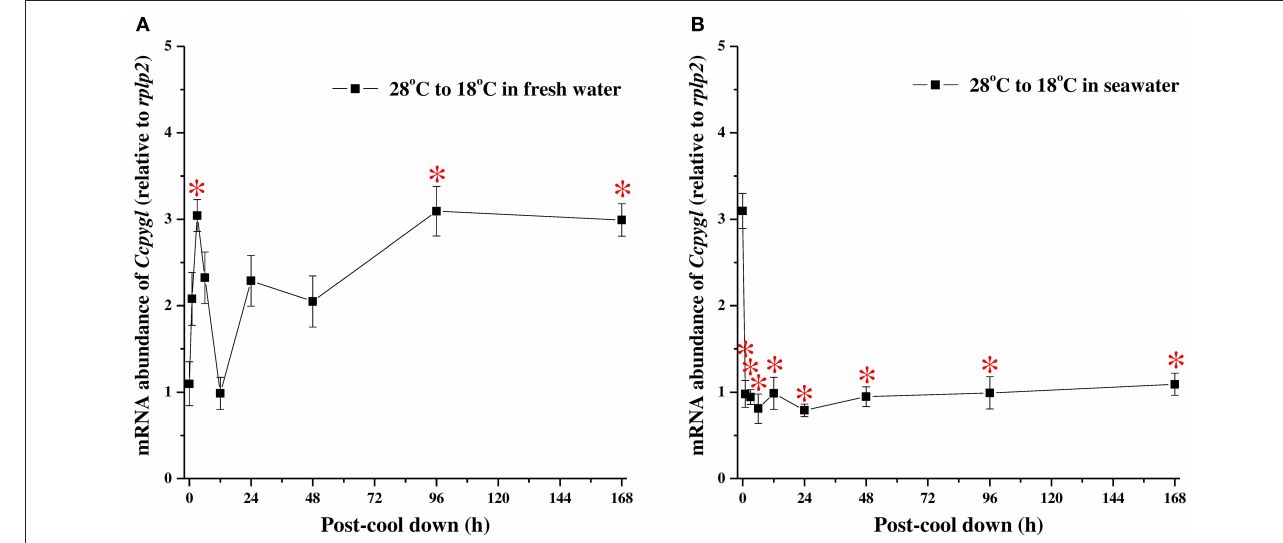
FIGURE 5 | The hypothermal stress experiments revealed time-course mRNA expression of Ccpygl in livers of (A) fresh water (FW) and (B) seawater (SW) milkfish. Values are means ± SEM, n = 6. The asterisks indicate significant differences ( P < 0.05) compared to the 0h fish using one-way ANOVA with Dunnett’s